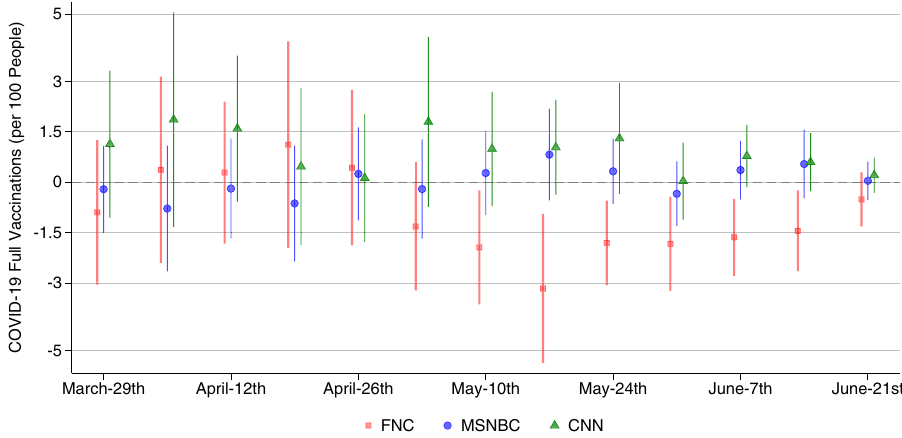
Figure 2. Effect of network viewership on weekly vaccination rates, 2021 (2SLS). Coefficient plots with 95% CIs from 2SLS regressions of the effect of one standard deviation changes in viewership on weekly vaccinations per 100 people. Viewerships are instrumented using the lineup channel positions. Regressions include demographic and cable-system controls. Standard errors are clustered by state. First-stage F-statistics: 13.85 (FNC), 4.45 (MSNBC) and 2.53